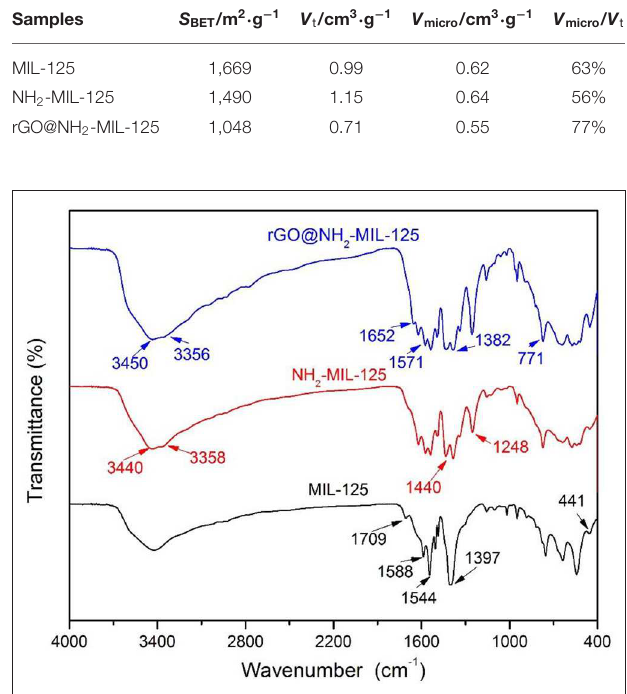
FIGURE 4 | FTIR spectra of the three acquired